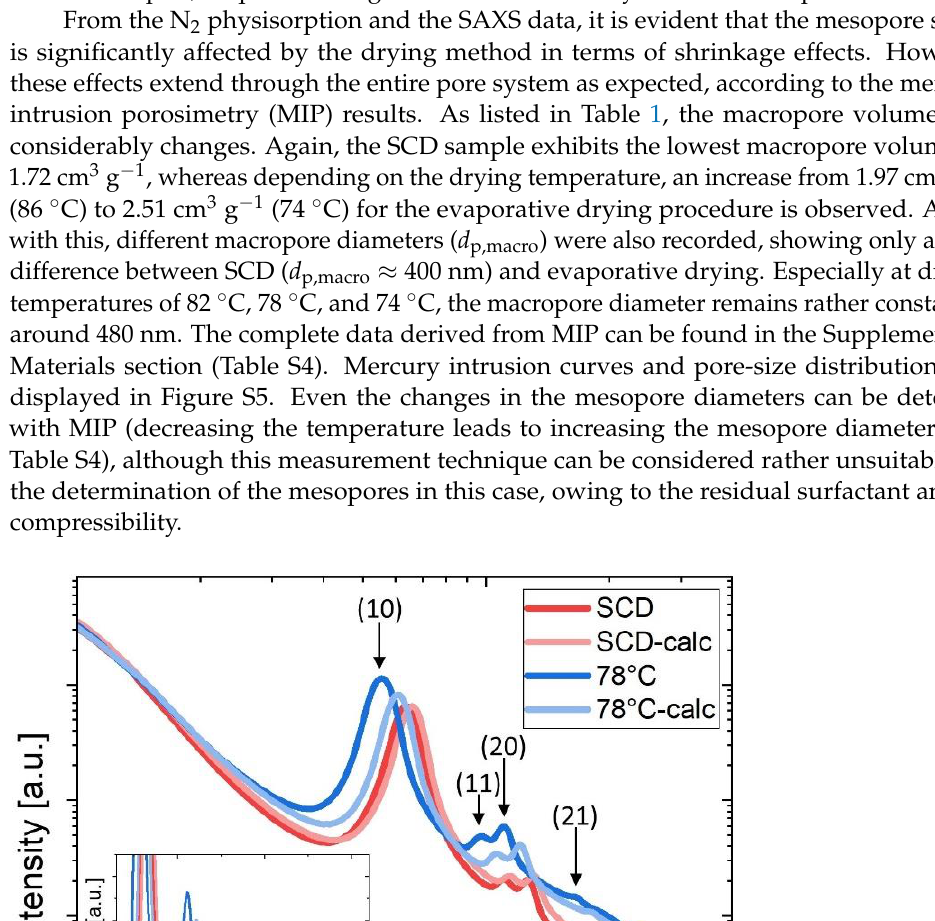
Figure 4. Selected scattering profiles from hierarchically organized porous silica materials dried via SCD (red) or via evaporative drying at 78 °C (blue). The lighter colors represent the respective calcined samples. The inset shows the data in a so-called Kratky plot, indicating a considerably higher diffuse scattering for the ambient dried sample [53].